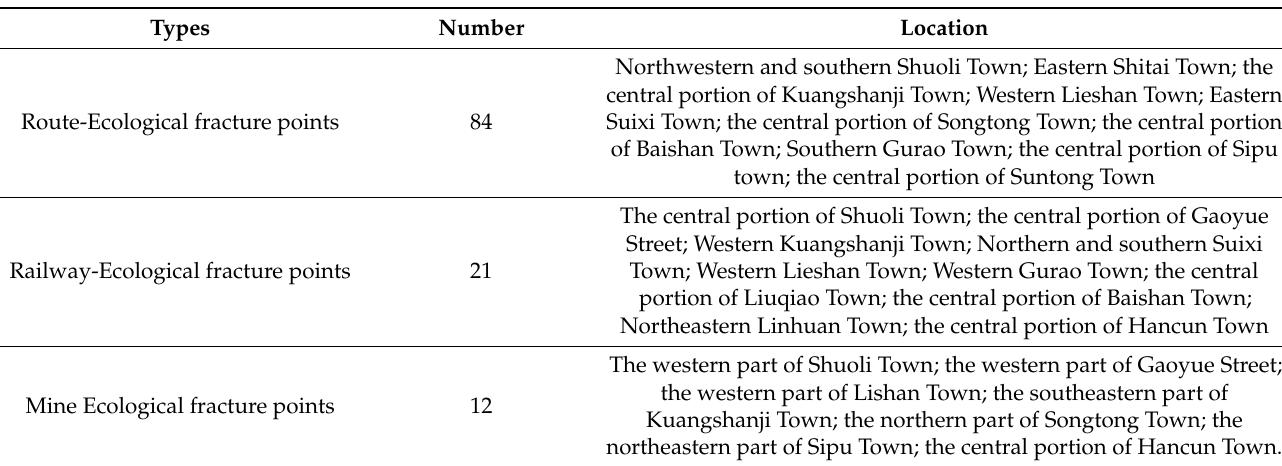
Table 6. Distribution of ecological fracture points in Huaibei